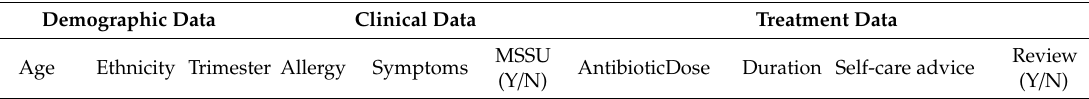
Table 1. Data collection tool.